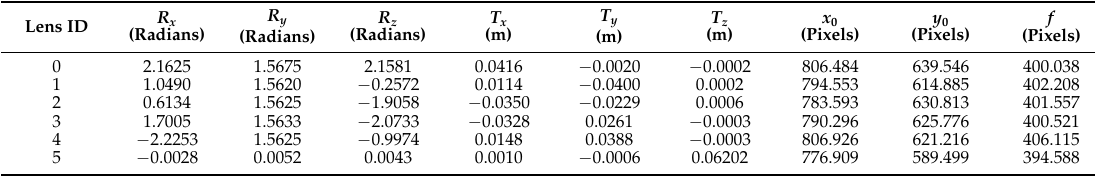
Table 2. Parameters of mono-cameras in the panoramic camera model (image size is 1616 × 1232 in pixels).